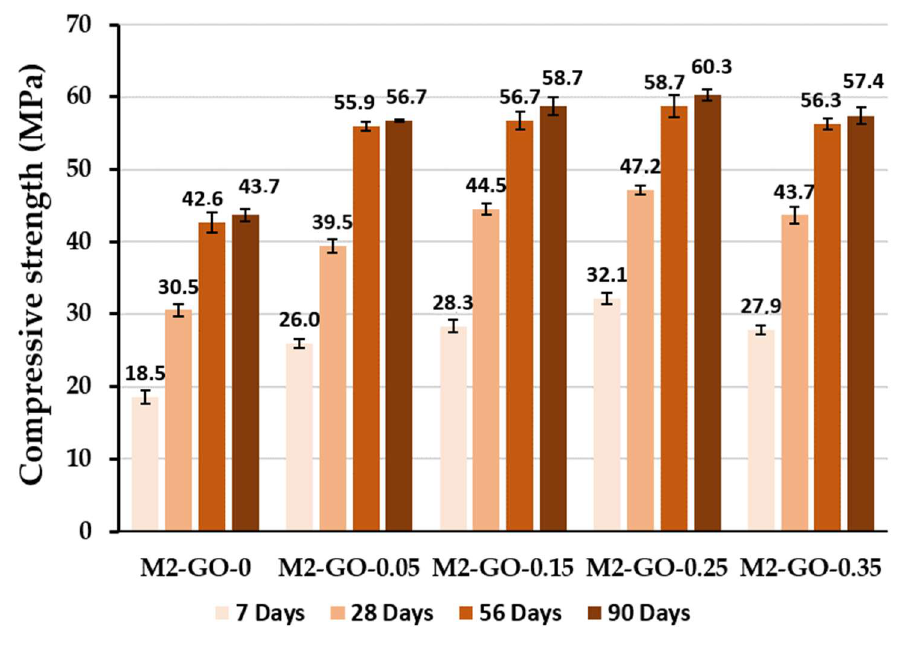
Figure 5. Compressive strengths of M2 mix (FA75-G25).